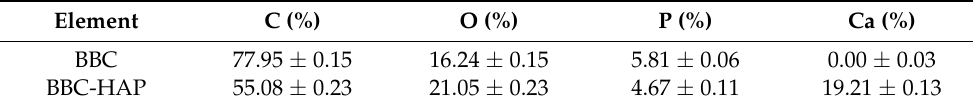
Table 1. Weight percentages of various elements present in BBC and BBC-HAP.